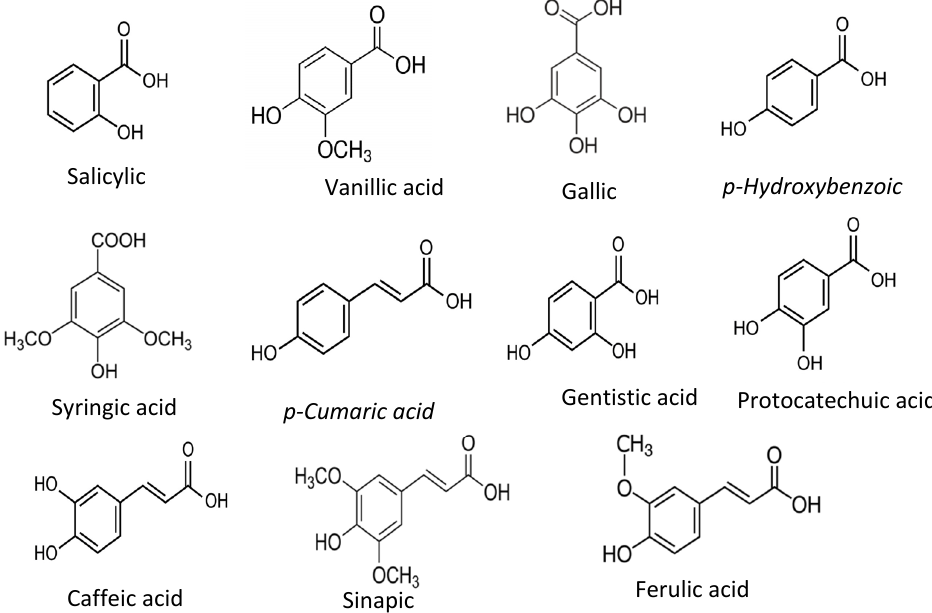
Figure 2. Common phenolic acids found in food plants.